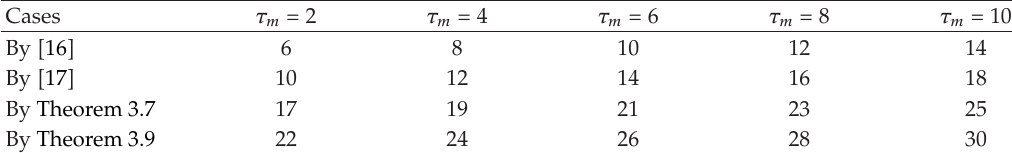
M for given τ m